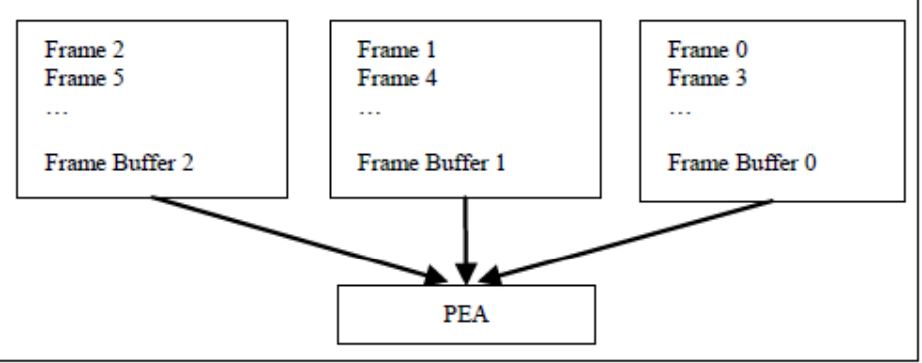
Figure 7. Architecture of Inter-E for VC-MRME. Three frame buffers are on chip to hold three reference frames.